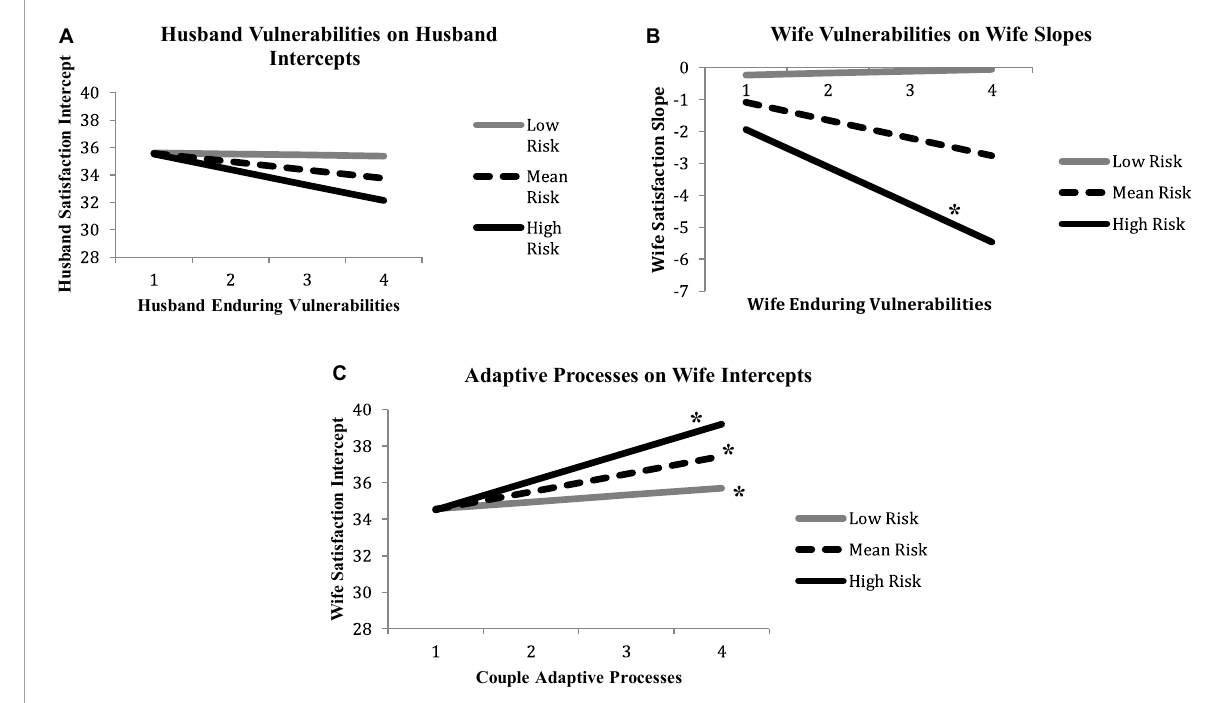
FIGURE3 Sociodemographic risk interacts with (A) husbands’ vulnerabilities to predict husband satisfaction intercepts, (B) wives’ vulnerabilities to predict wives’ satisfaction slopes, and (C) adaptive processes to predict wives’ satisfaction intercepts. Asterisks denote statistically significant estimates of simple